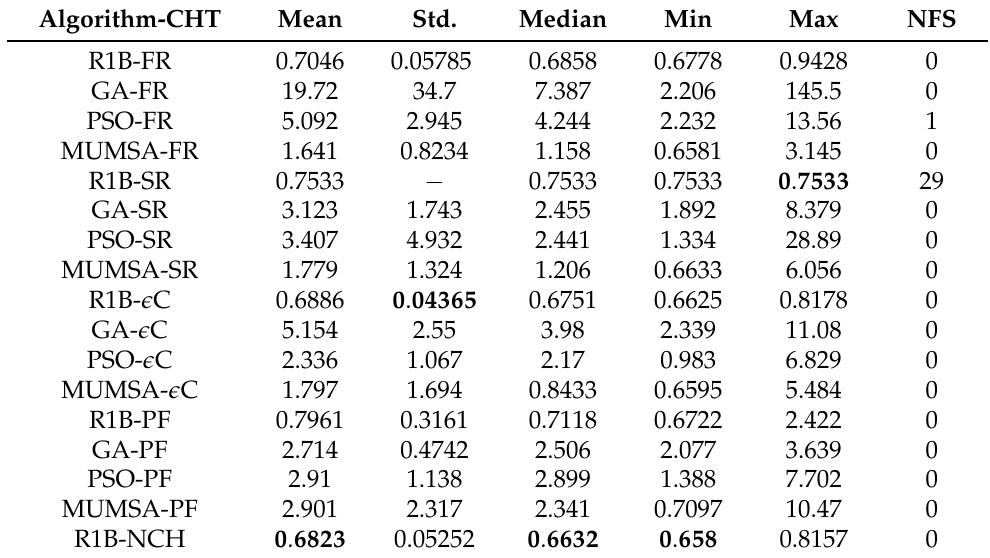
Table 7. Descriptive statistics of the obtained results for each metaheuristic algorithm in study case 2 with the trajectory 1.